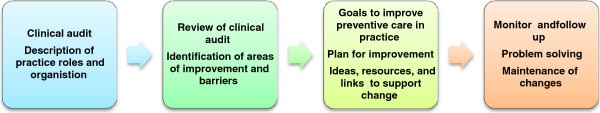
The intervention.